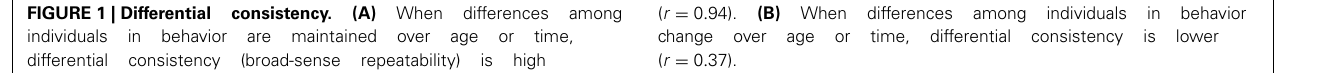
( r = 0 . 94). (B) When differences among individuals in behavior change over age or time, differential consistency is lower ( r = 0 .